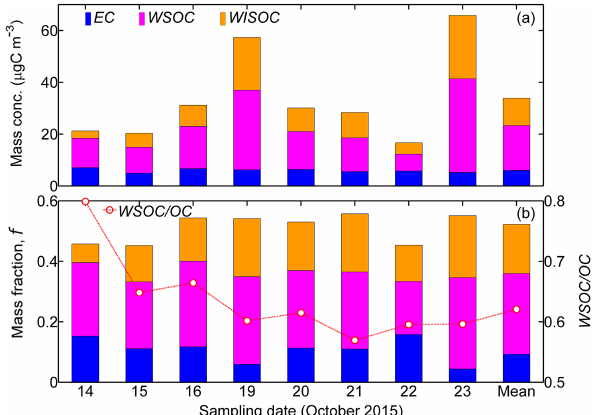
Figure 4. (a) Mass concentration (“Mass conc.”, µgCm − 3 ) and (b) corresponding mass fraction, f , of the carbon contents includ- ing EC, WSOC, and water-insoluble OC (WISOC) in PM 2 . 5 filter samples. The WSOC / OC ratio is also displayed by the scattered dots in (b) . All the corresponding temporal mean results are shown as “Mean”. The WSOC fraction was exclusively higher than that of WISOC or EC, highlighting the dominance of WSOC in the carbon content of PM 2 . 5 filter samples. In general, the EC fraction fluctu- ated around 10.0% of the total PM 2 . 5 mass.